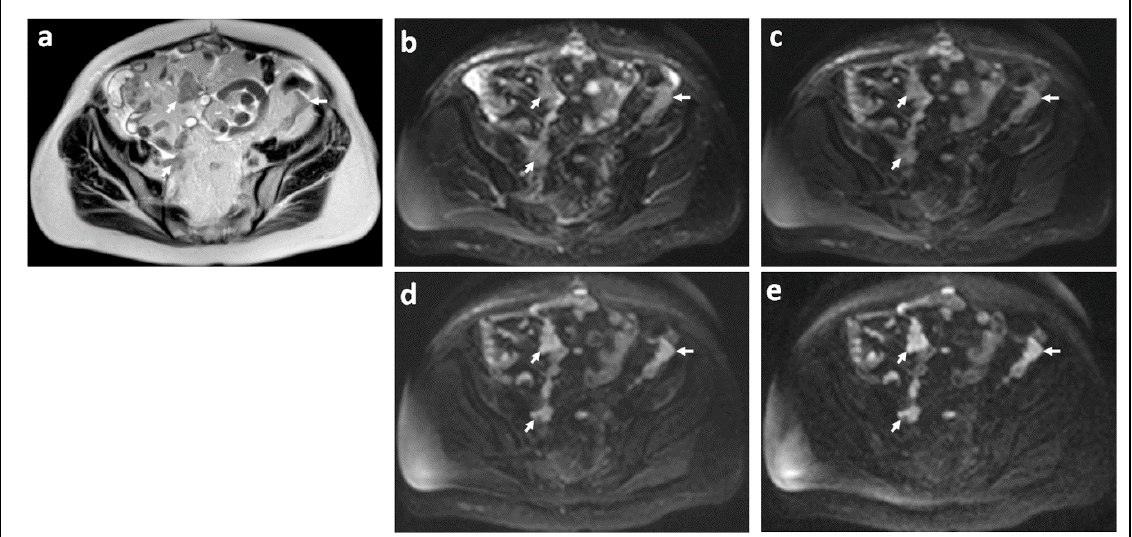
Figure 1. Peritoneal metastases in high grade serous ovarian cancer showing increasing lesion conspicuity with increasing b -value : T2-W ( a ) and DW-MRI at b -values of 0 s/mm 2 ( b ), 100 s/mm 2 ( c ), 500 s/mm 2 ( d ), and 900 s/mm 2 ( e ). The irregular metastatic deposits on the surface of the bowel and in the mesentery (arrows) show diffusion restriction. They increase in conspicuity and contrast as diffusion weighting increases because they retain signal while signal from adjacent normal tissues diffuses away.